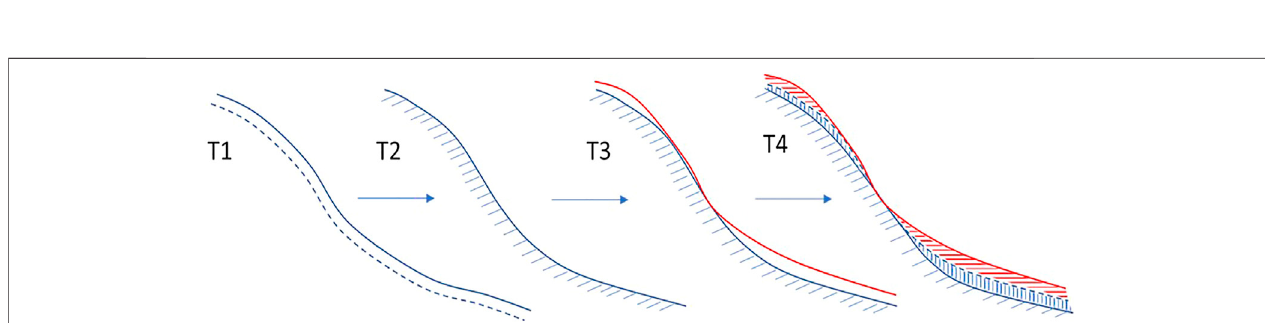
FIGURE 7 | Overview of the proposed recharge monitoring methodology. T1 — initial scan of channel. T2 — debris- fl ow has occurred and scoured channel to the bedrockbaseline(idealized).T3 — channelbeginstorechargefromrockfallandrockslides.T4 — debris- fl owoccurs.Usingthebaseline,thedegreeofdebrisandbedrock incision can be